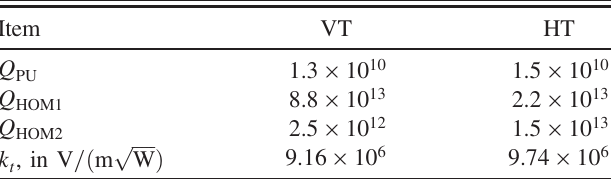
TABLE III. Comparison of rf calibrations in the vertical and horizontal